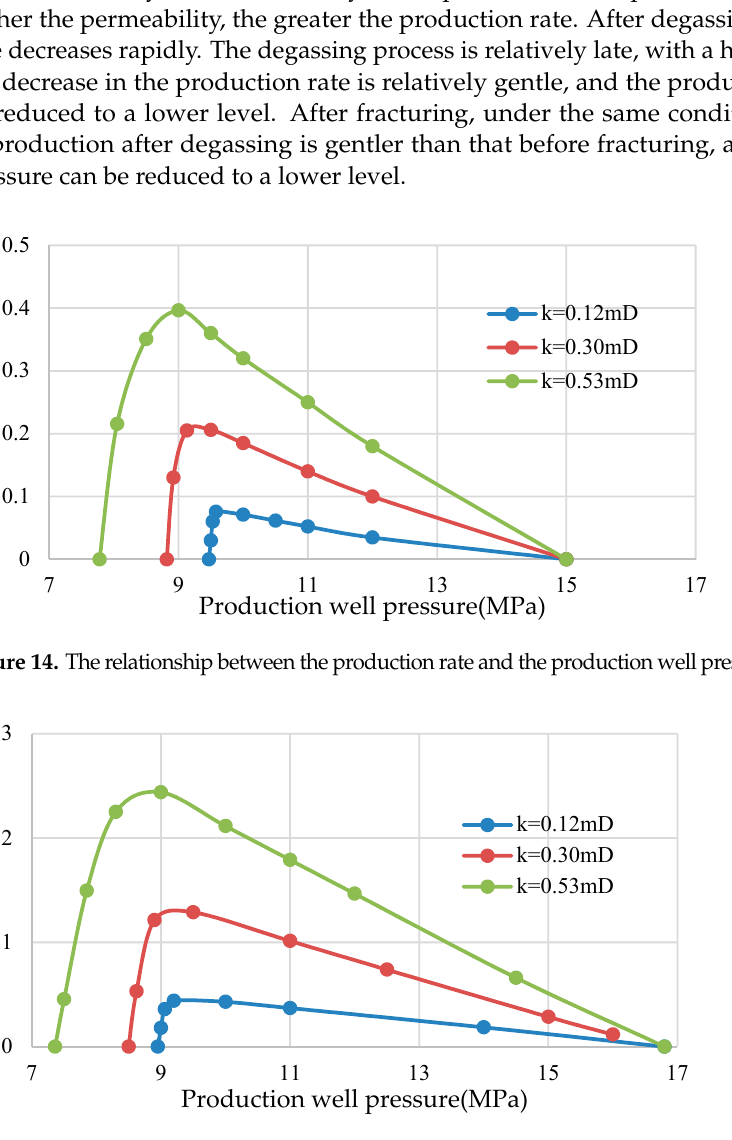
Figure 15. The relationship between the production rate and the production well pressure after fracturing.